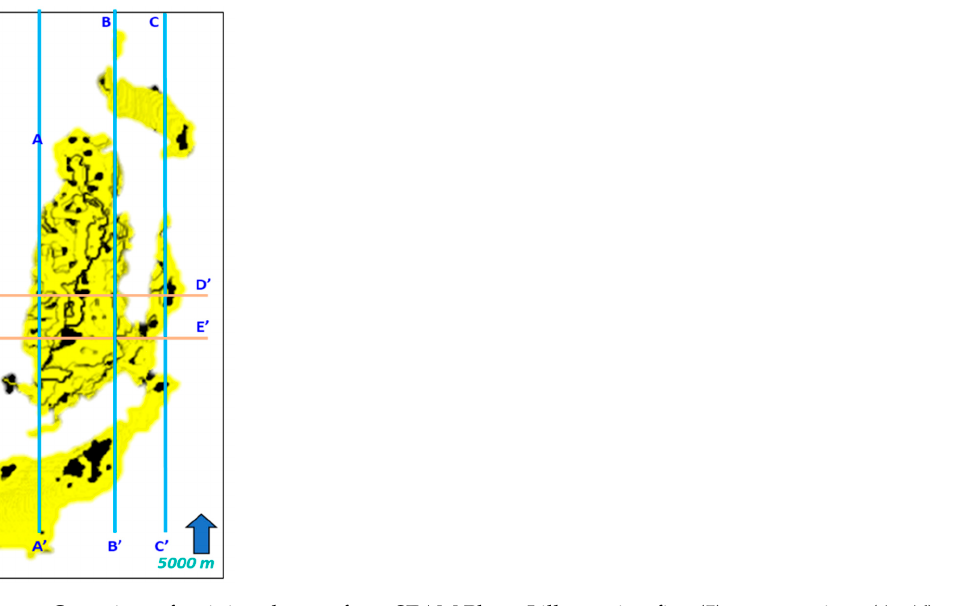
Table 3. Results in the two categories, with dropout variations, in the test dataset. All metrics are in the range of 0 to 1, with larger values being better. The best-performing model for every metric is highlighted in bold. Input Attributes